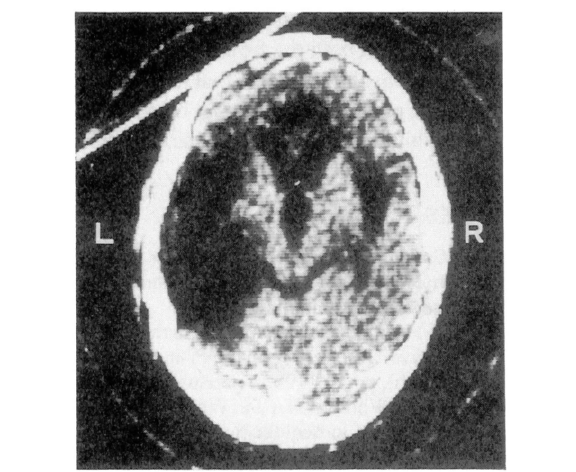
FIG. 3. Brain X-ray CT. A transeverse axial tomographic image at a height 25 mm above the orbitomeatal base line shows bilateral low density areas in the lower frontal and temporal lobes, with massive lesions in the left lower temporal lobe. R, right; L,